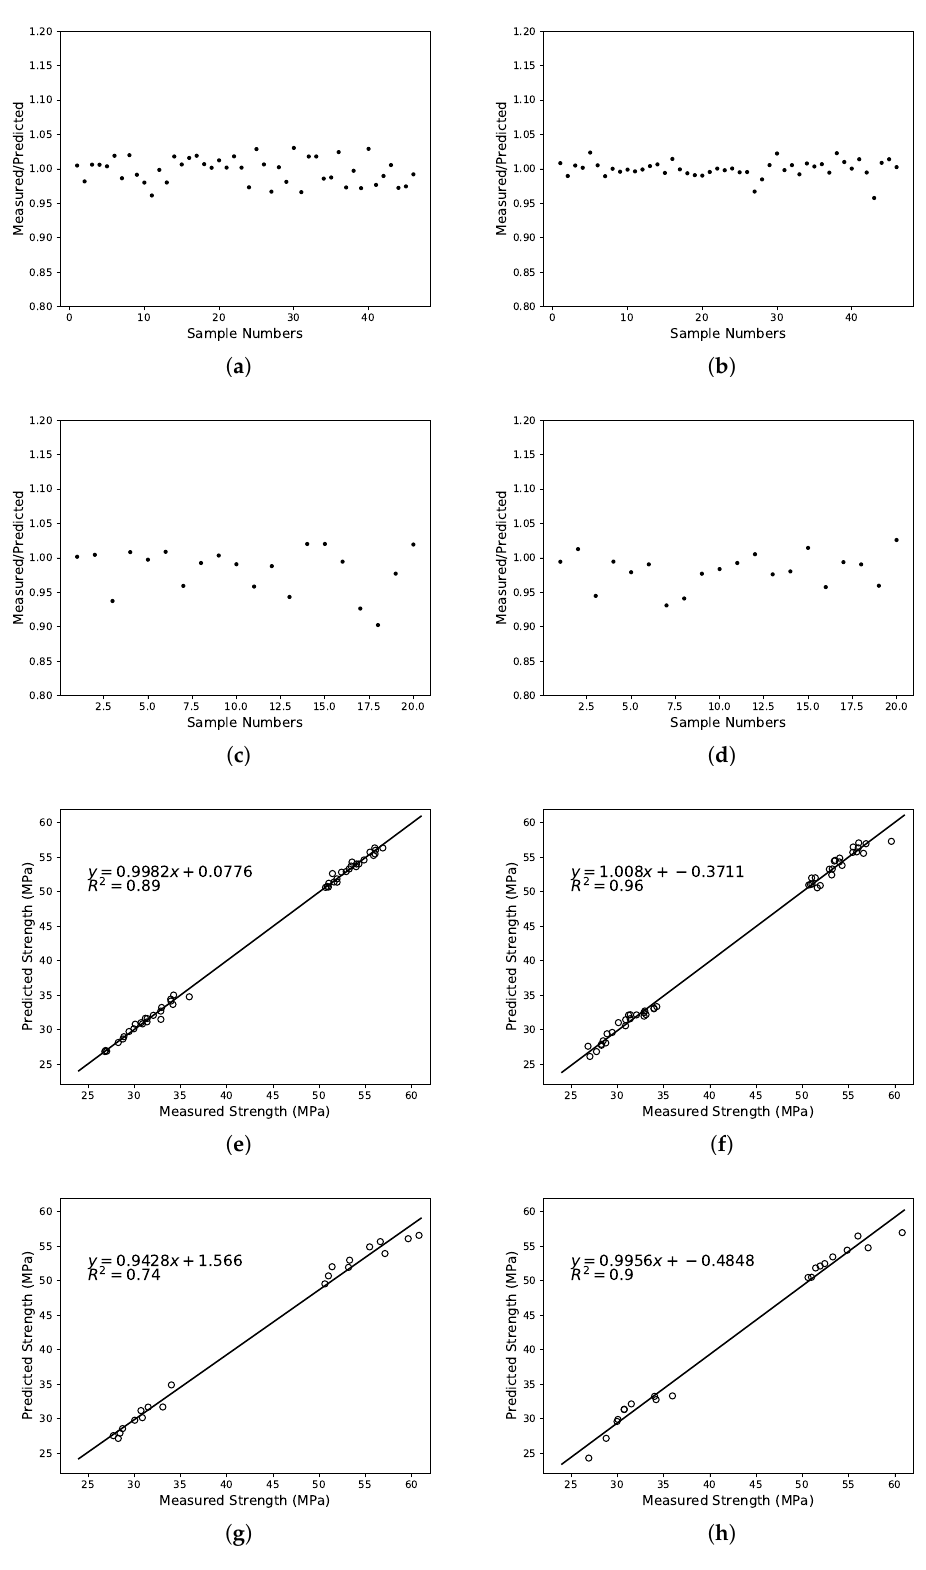
Figure 5. Comparison of the ration between the measured and predicted compressive strength using SVM and LS-SVM. The ratio: ( a ) SVM in training set, ( b ) LS-SVM in training set, ( c ) SVM in test set, ( d ) LS-SVM in test set; The correlation: ( e ) SVM in training set, ( f ) LS-SVM in training set, ( g ) SVM in test set, ( h ) LS-SVM in test set.